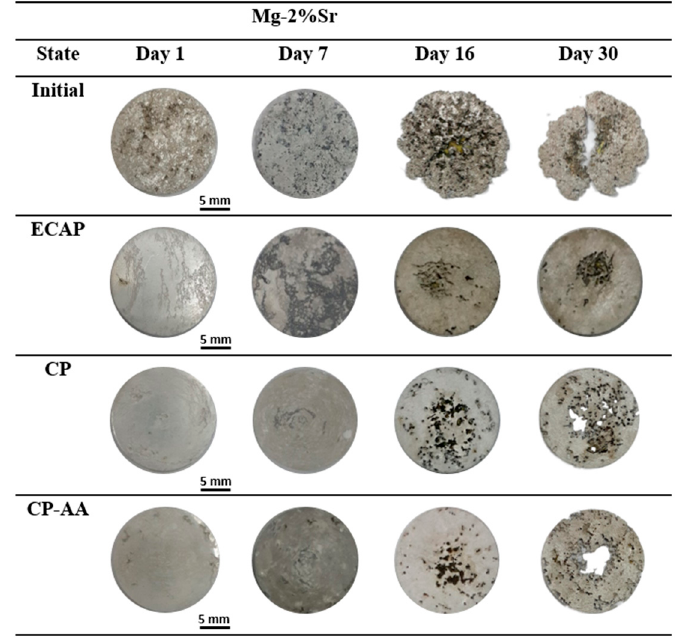
Figure 6. Images of specimens of the Mg-2Sr alloy in different structural states after immersion in Ringer’s solution over exposure time ranging from 1 to 30 days. Table 3. Corrosion rates of the Mg-2Sr alloy in different structural states.